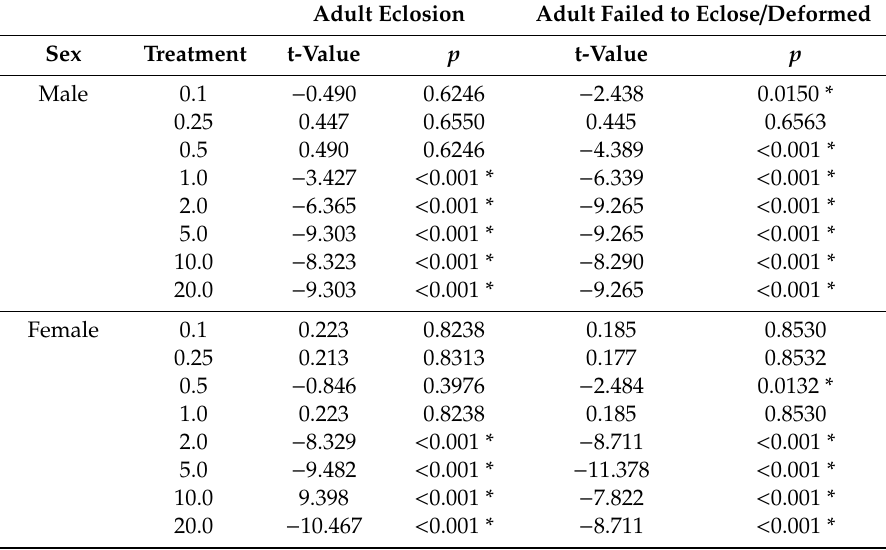
Table 3. E ff ects of treatment dosage on a) likelihood of adult eclosion; and b) likelihood of pupal death / adult eclosion with a deformity (Multiple logistic regression; ‘*’ represents a significant di ff erence in likelihood versus control (untreated) pupae ( p =